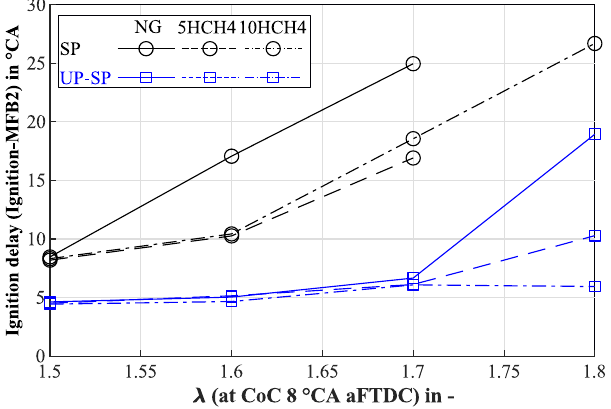
Figure 4. Ignition delay at constant CoC = 8 °CA aFTDC.